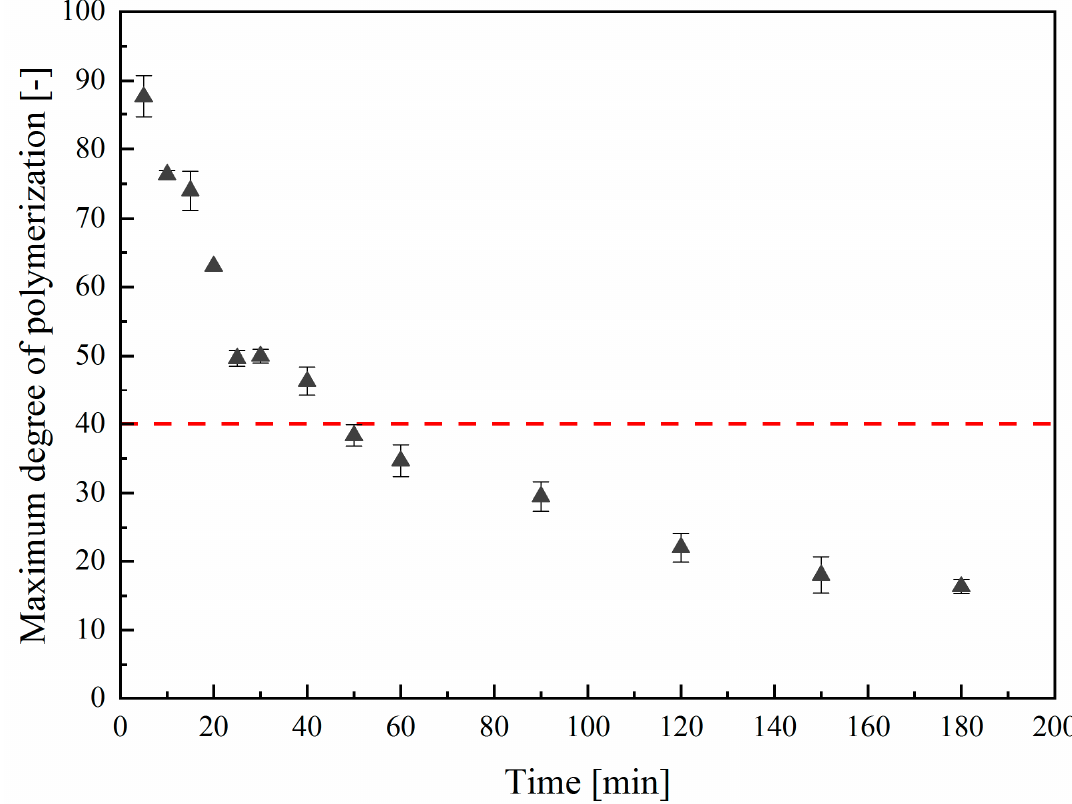
Figure 4. Maximum degree of polymerization as a function of hydrolysis time at 90 °C. LC polySia was subjected to a 3-h thermal hydrolysis at 90 °C. The measurement was carried out in triple determination and then the maximum degree of polymerization was subsequently determined using DMB-HPLC.